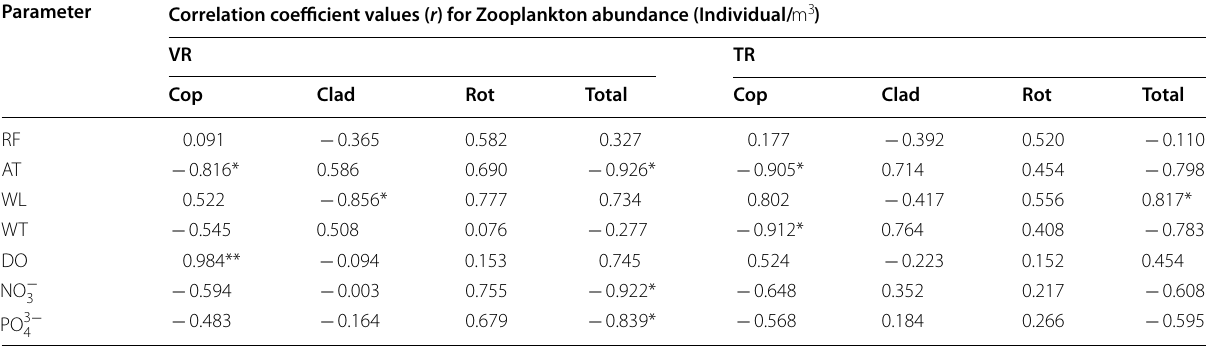
*Correlation is significant at the 0.05 level (1—tailed) (Cop—Copepoda; Clad—Cladocera; Rot—Rotifera) **Correlation is significant at the 0.01 level (1—tailed)